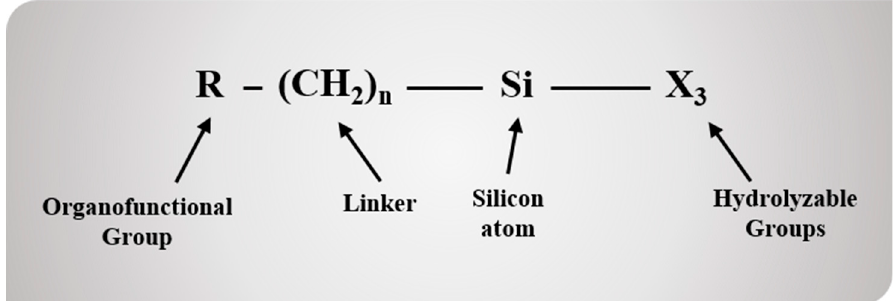
Figure 1. The chemical structure of the conventional silane coupling agents (SCA)s.